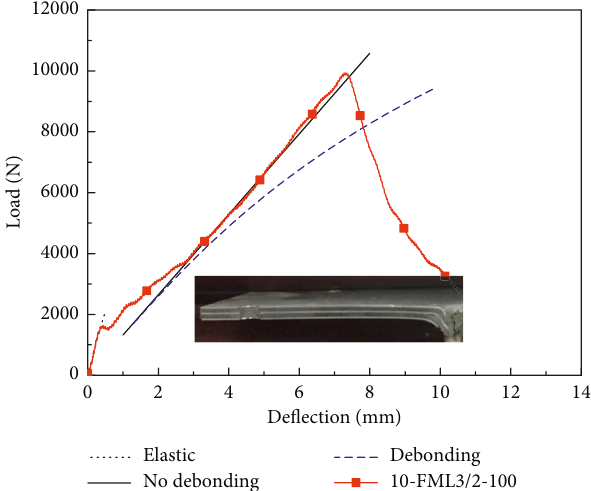
Figure 10: Load-deflection relation of the thick BFML plate without debonding.